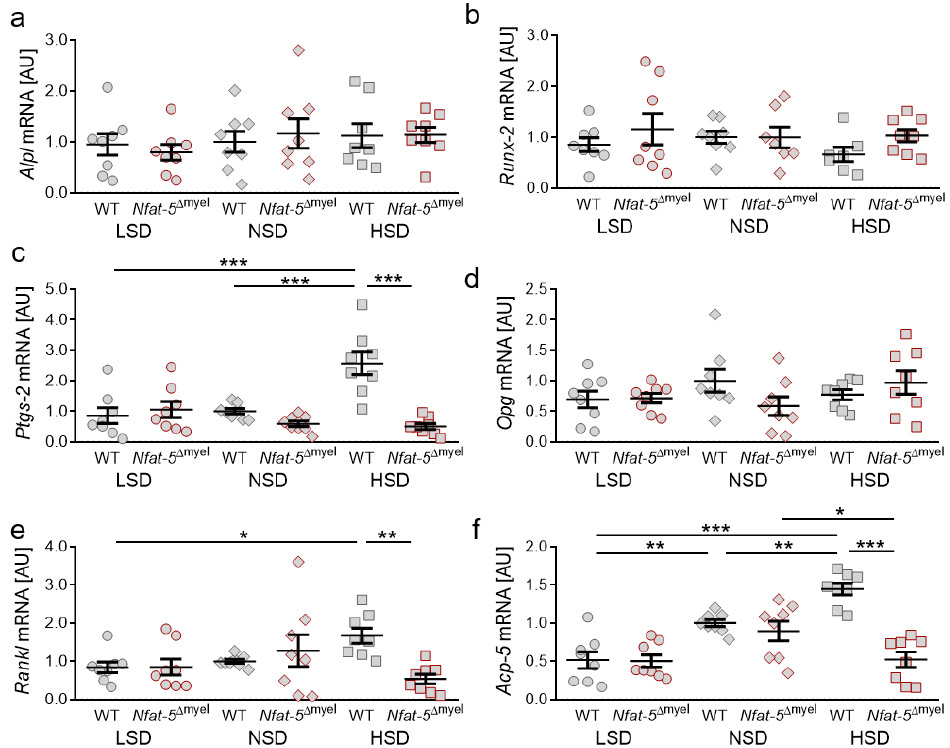
Figure 5. Gene expression of Alpl ( a ), Runx-2 ( b ), Ptgs-2 ( c ), Opg ( d ), Rankl ( e ) and Acp-5 ( f ) with LSD, NSD or HSD in control or Nfat-5 Δmyel mice in dental-periodontal tissue at the first upper molar at the orthodontically treated side, assessed with RT-qPCR ( n = 8). Symbols represent single data points, horizontal lines the arithmetic mean and vertical lines the standard error of the mean. AU: arbitrary units, OTM: orthodontic tooth movement, LSD: low salt diet, NSD: normal salt diet, HSD: high salt diet. Statistics: ANOVA followed by Holm–Sidak multiple comparison tests or Welch-corrected ANOVA with Games–Howell post-hoc tests. * p < 0.05; ** p < 0.01; *** p <